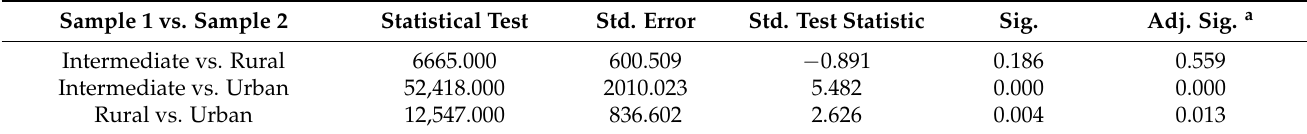
Table 10. Pairwise comparisons of urbanization degree.